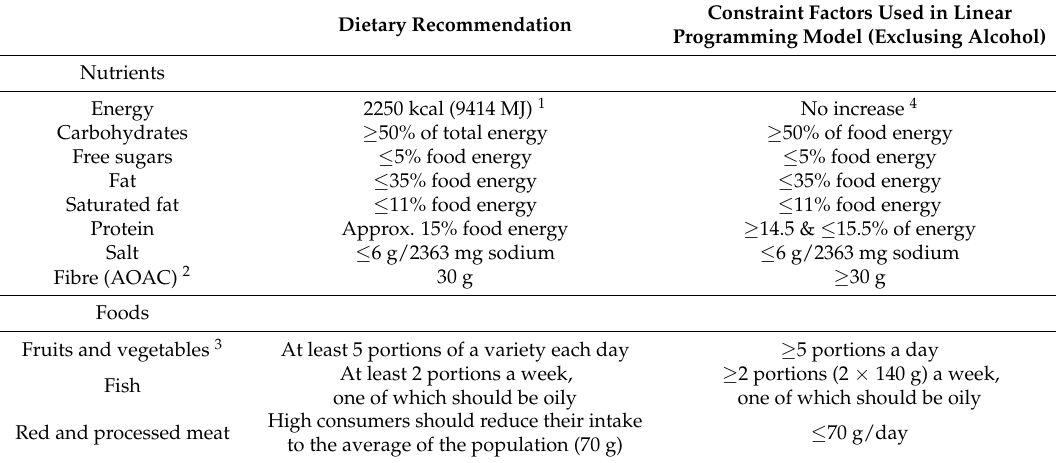
Table 2. Mathematical constraint factors (used to ensure dietary recommendations met in solved linear programming model) utilised to develop the visual reflecting government dietary